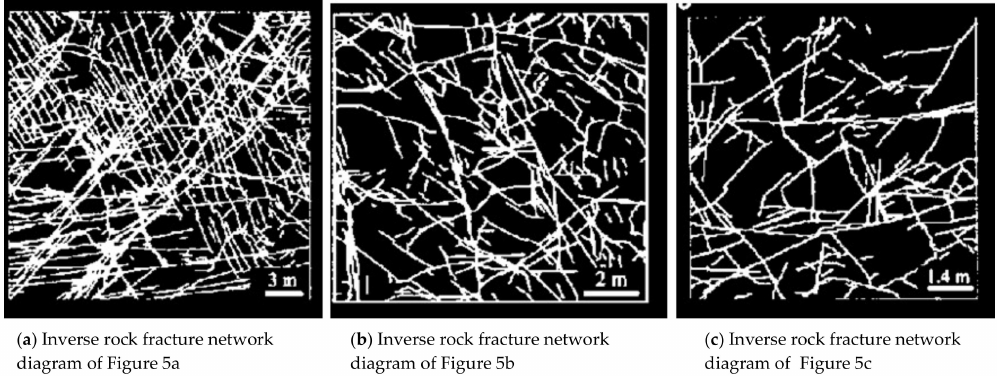
Figure 6. The three inverse rock fracture network diagrams of Figure